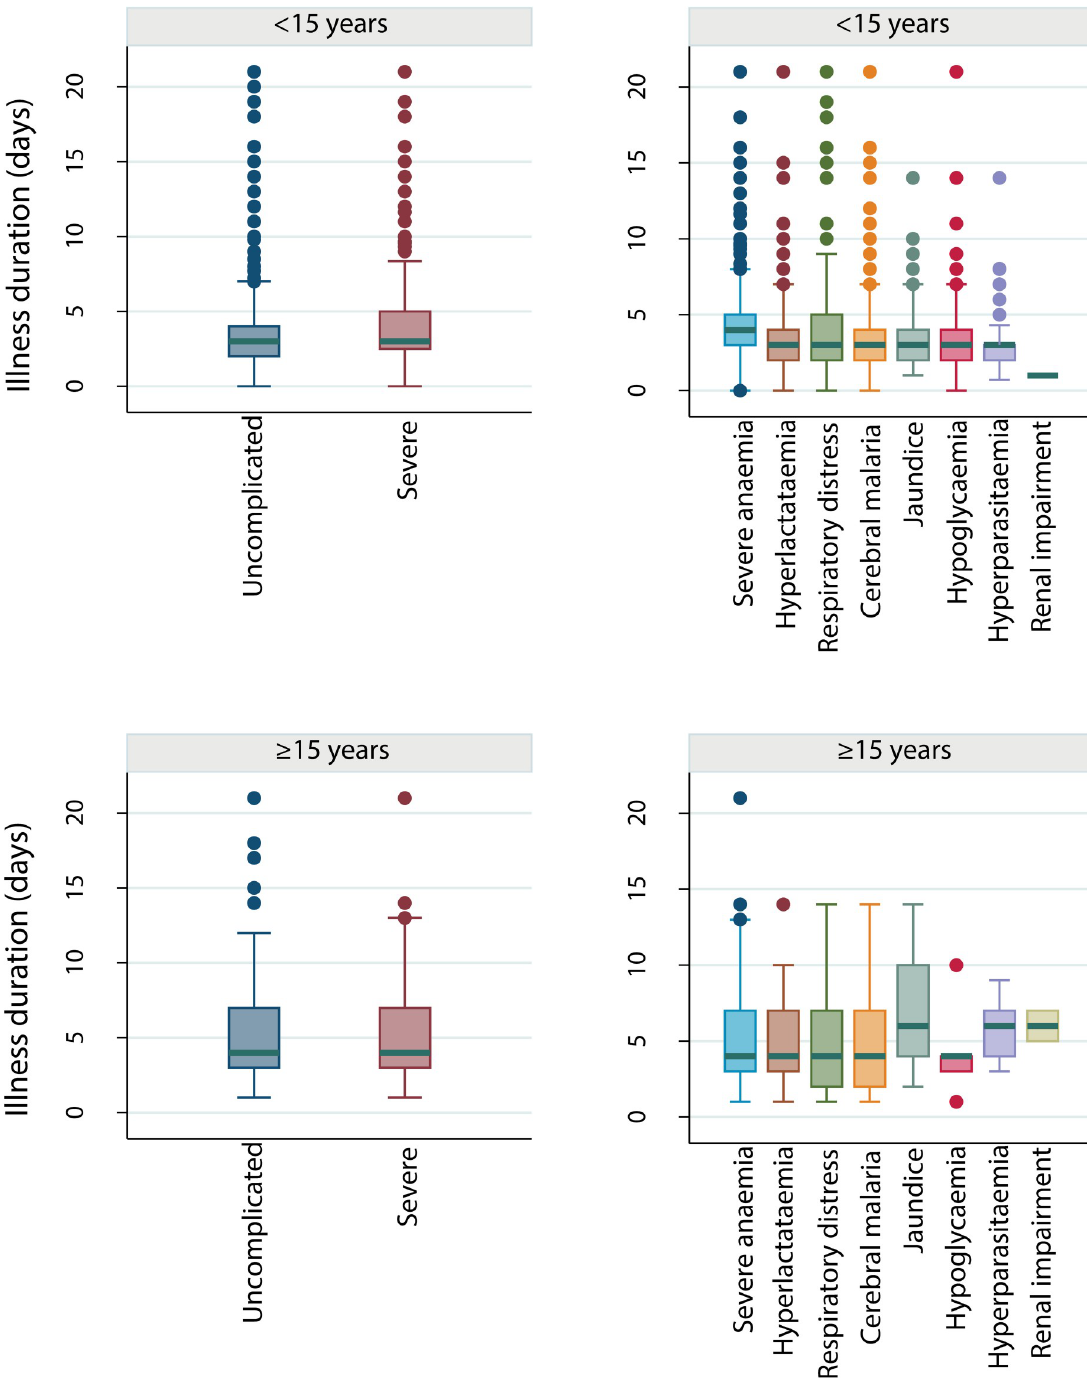
Fig 2. Illness duration (in days) prior to arrival at the health facility by SM phenotype and age group. Box-and-whisker plots showing median and IQR of duration of illness/fever in children and adults stratified by severity group (ages < 15 years: N UM = 3,277, N SM = 3,708; ages � 15 years: N UM = 300, N SM = 226). Outliers (observations that are 1.5 × IQR from the lower or upper quartiles) are denoted. Extreme outliers, defined as duration of illness of over 3 weeks, are omitted from these plots (0.6% of cases [20 UM and 25 SM] were omitted). SM, severe malaria; UM, uncomplicated